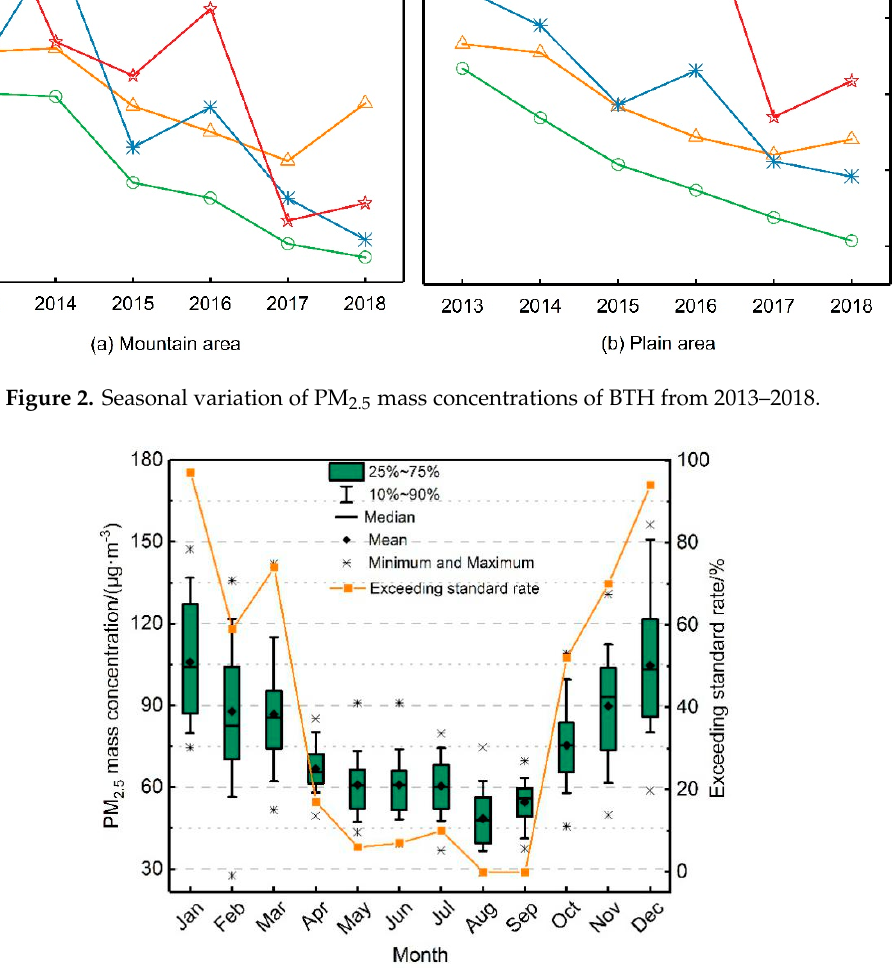
Figure 3. Box-plot of monthly PM 2.5 mass concentration of BTH from 2013–2018.The proportion of days on which the PM 2.5 concentration exceeded 75 μ g/m 3 per month to the total number of days per month is the exceeding rate.